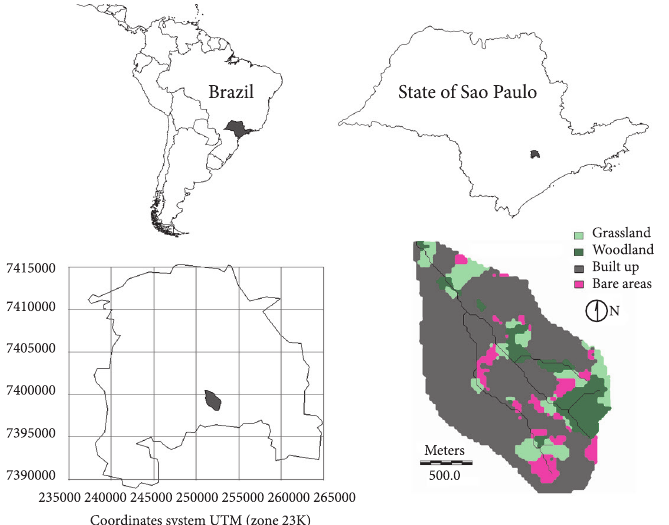
Fig. 1. Upper left: Brazilian states (highlighting State of Sao Paulo). Upper right: Boundaries of State of Sao Paulo (highlighting Sorocaba). Bottom left: Boundaries of Sorocaba (highlighting the studied watershed). Bottom right: Land cover map of studied map (modified from Silva 2012) Table 1. Land cover categories considered for study, percentage of occurrence, brief characterization of each land cover category and number of soil samples taken in each land cover category (source: modified from Anderson 1976) Land cover